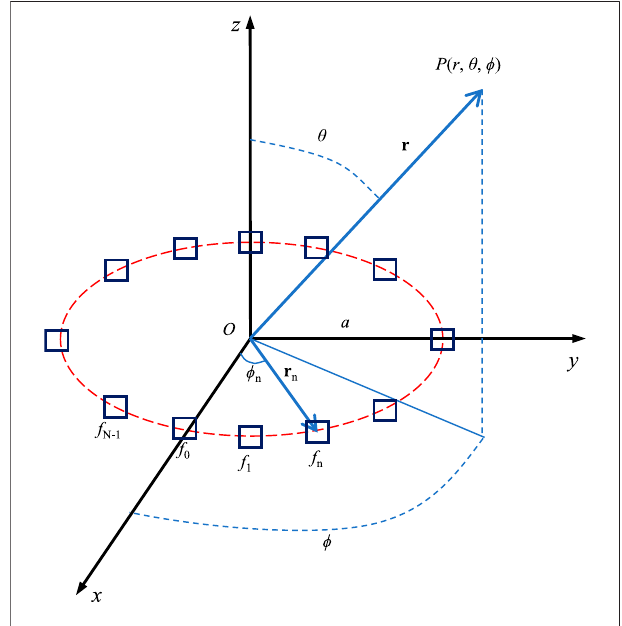
FIGURE 1 | N -antenna CFDA